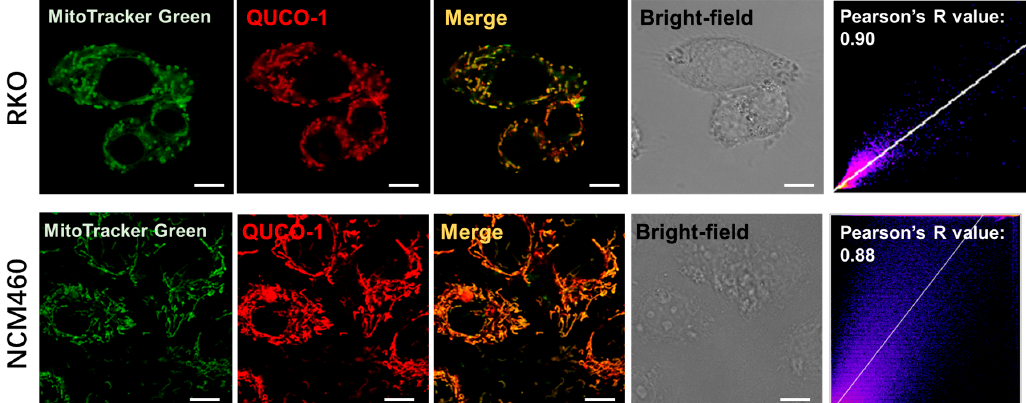
Figure 1. Colocalization of QUCO-1 (1 µM) with mitochondria in RKO or NCM460 cells. Commercial mitochondrial dye (MitoTracker Green) was used to identify mitochondria. Scale bar: 5 µm. Pearson’s R scatterplot and value between QUCO-1 and MitoTracker Green signal are also shown. QUCO-1 : E x = 550 nm and E m = 650 nm.